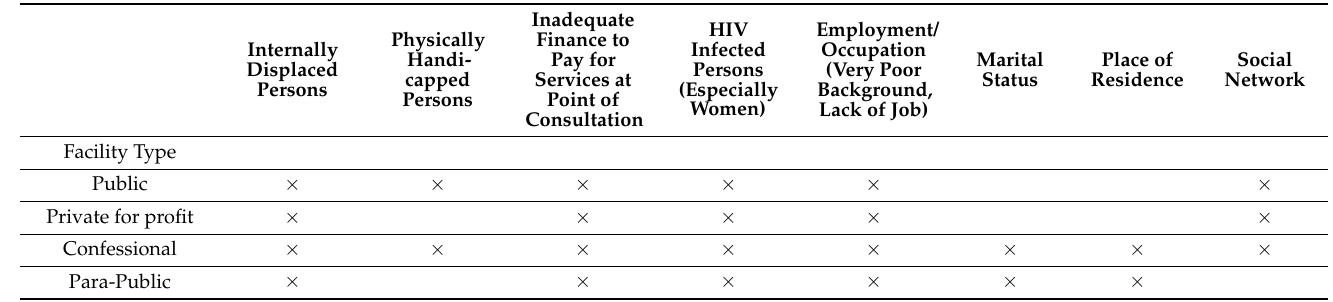
Table 4. Criteria for defining and identifying poor and vulnerable as reported by health facility administrators.